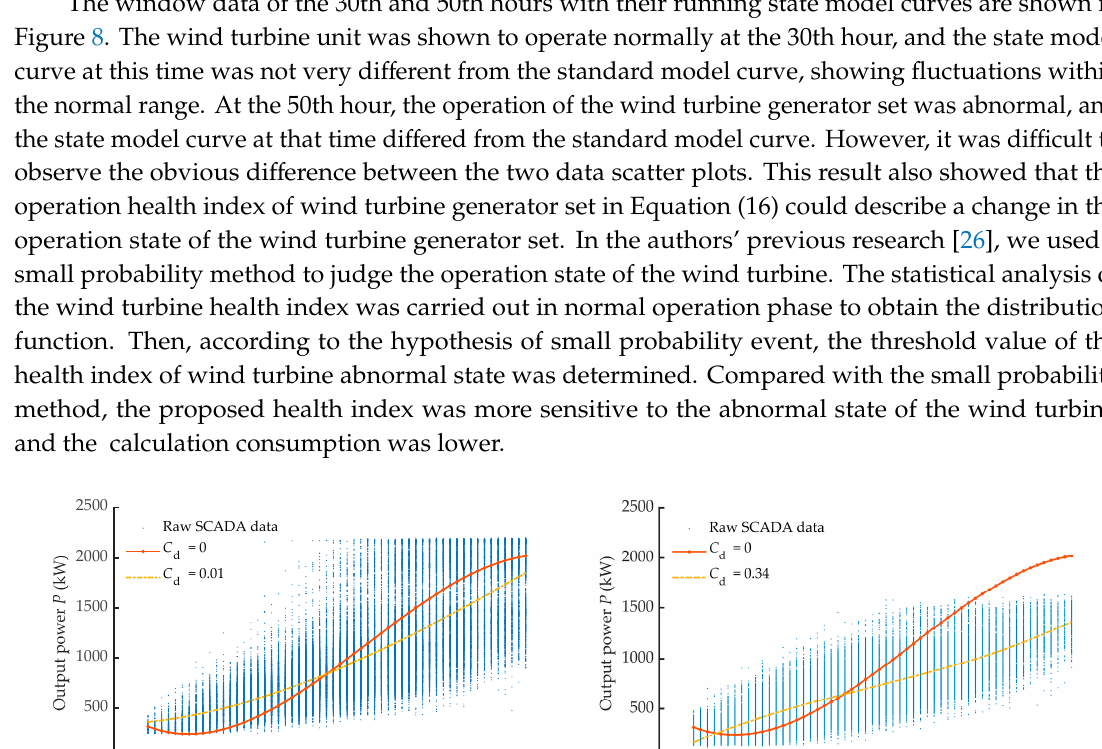
Figure 8. Comparison of state model curves and standard state model curves at different times.